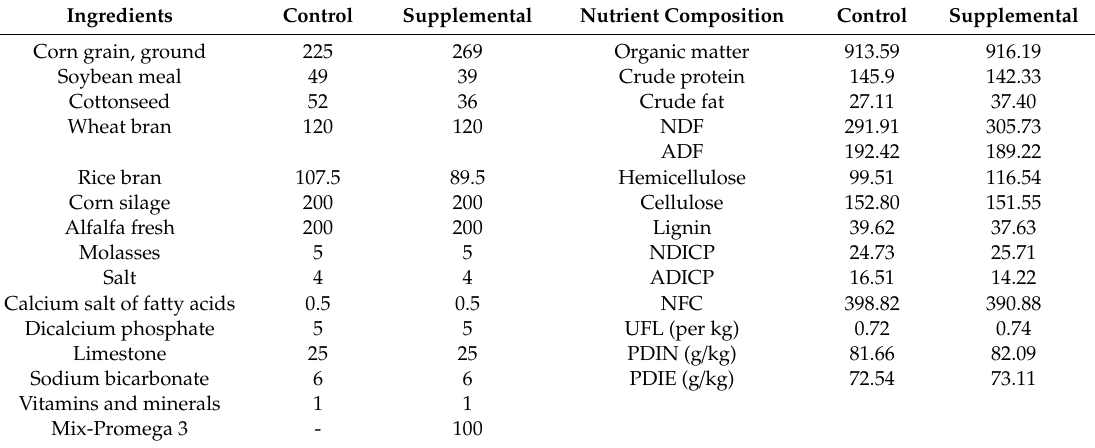
Table 1. Ingredients and nutrient composition (g / kg) of the two experimental diets (control and supplemental).